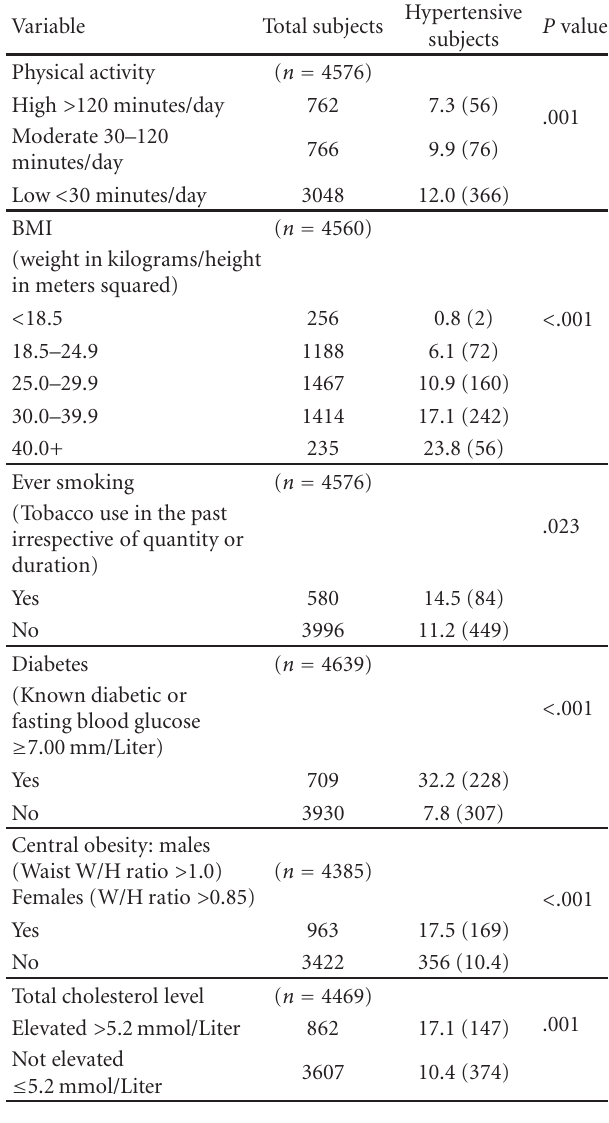
Table 2: Prevalence of hypertension according to level of physical activity, obesity, smoking, diabetes, and cholesterol